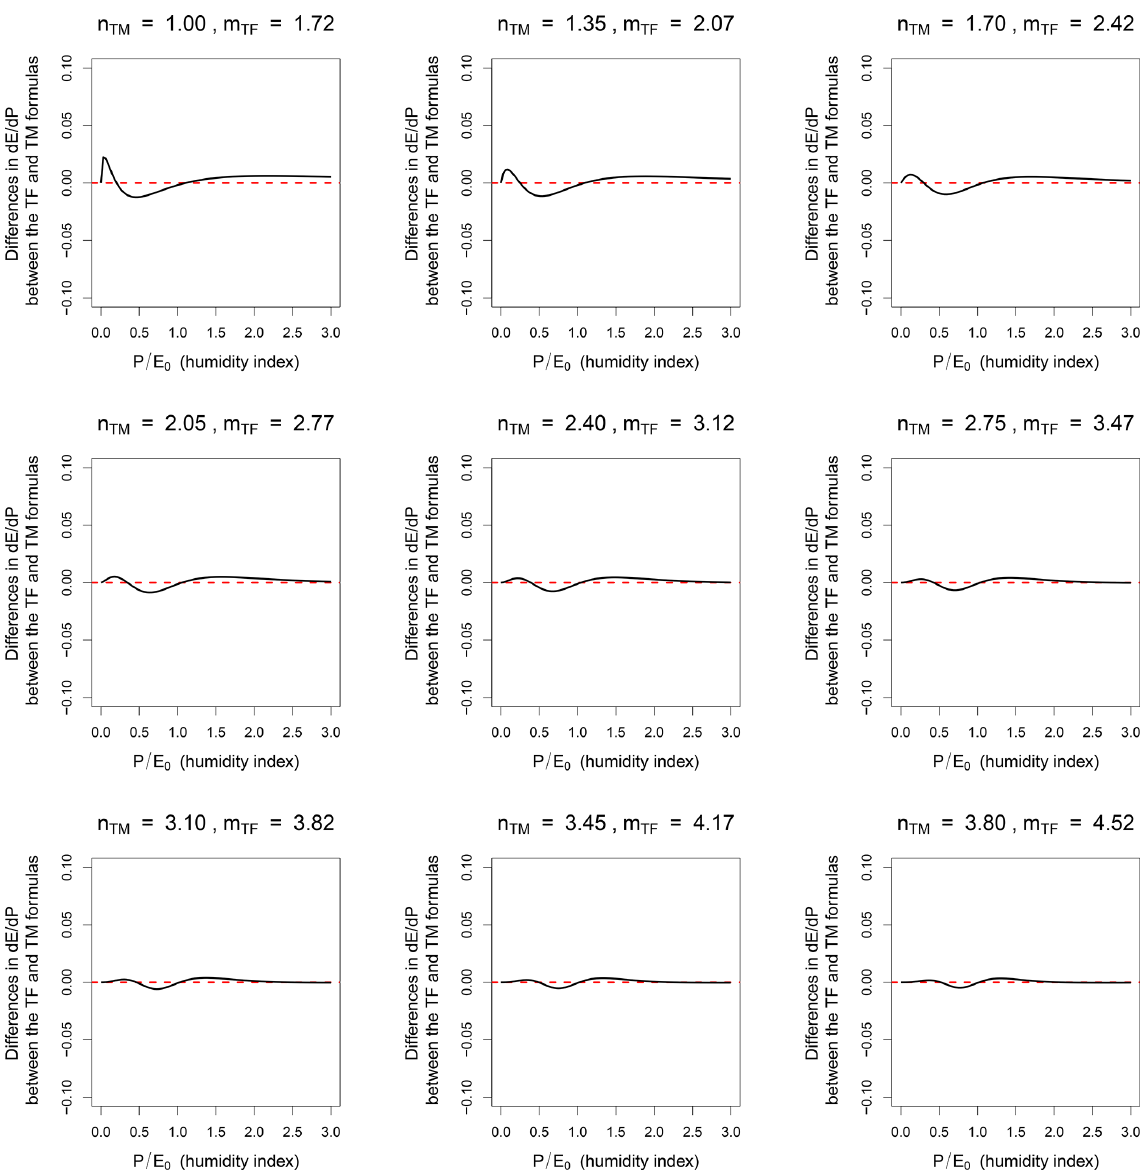
Figure 2. Illustration of the similarity between the Turc–Mezentsev (TM) and Tixeront–Fu (TF) formulas for a range of values of n (the parameter of the TM formula) and m (the parameter of the TF formula), using the Yang et al. (2008) relationship: m = n + 0 . 72: difference in the partial differentials ∂E ∂P